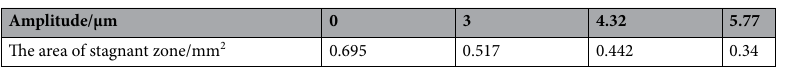
Table 2. The area of stagnant zone of different